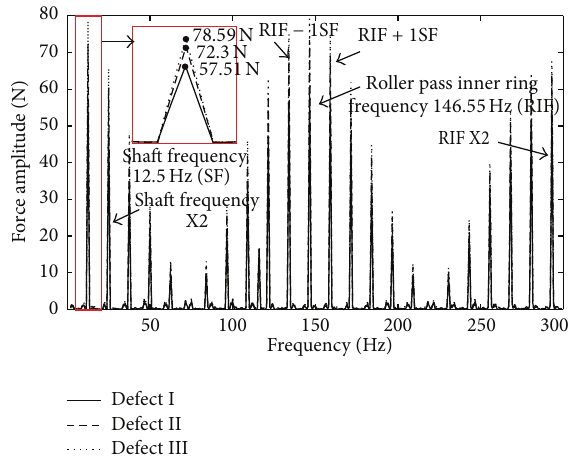
Figure 13: Defect size: force spectrum for defect on inner raceway in vertical direction.